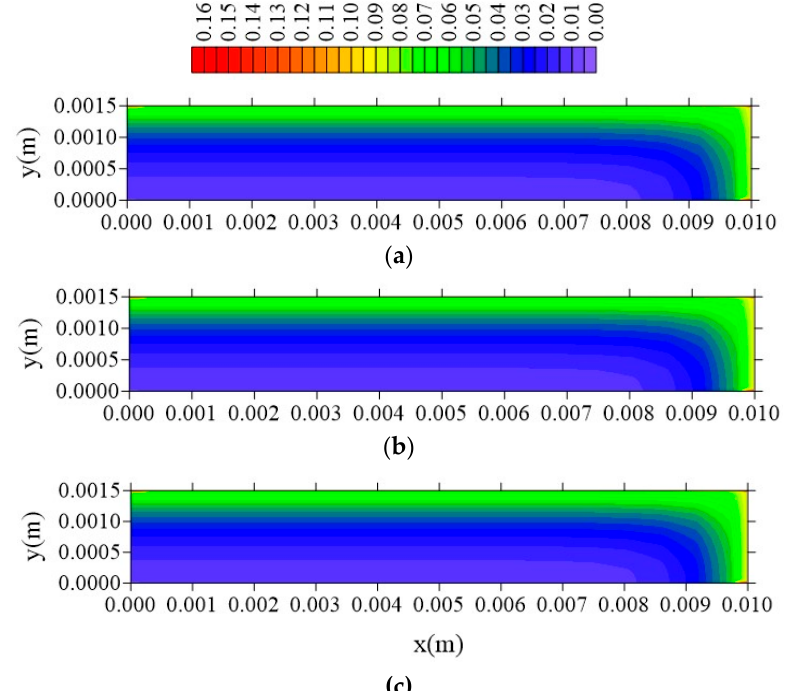
Figure 19. Distribution of the entrapped solute concentration (S in kg / kg) in the plan z = R z / 2 and di ff erent distances l x (t = 211 h; Cases 8, 9, and 10). In which ( a ) l x = 0.01 m; l y = 0.01 m and l z = 0.1 m; ( b ) l x = 0.1 m; l y = 0.01 m and l z = 0.1 m; ( c ) l x = 1 m; l y = 0.01 m and l z = 0.1